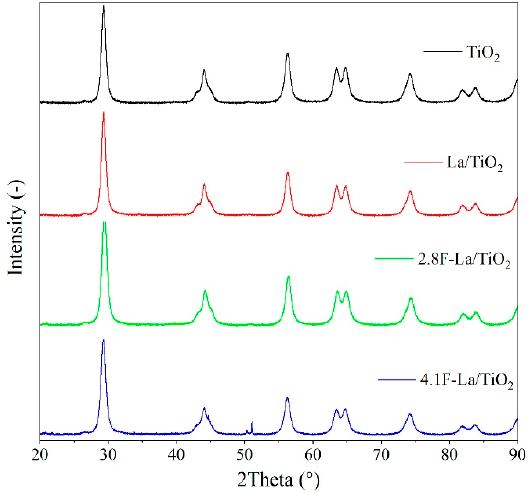
Figure 1. XRD patterns of investigated photocatalysts. Table 2. Structural and microstructural properties of investigated photocatalysts.